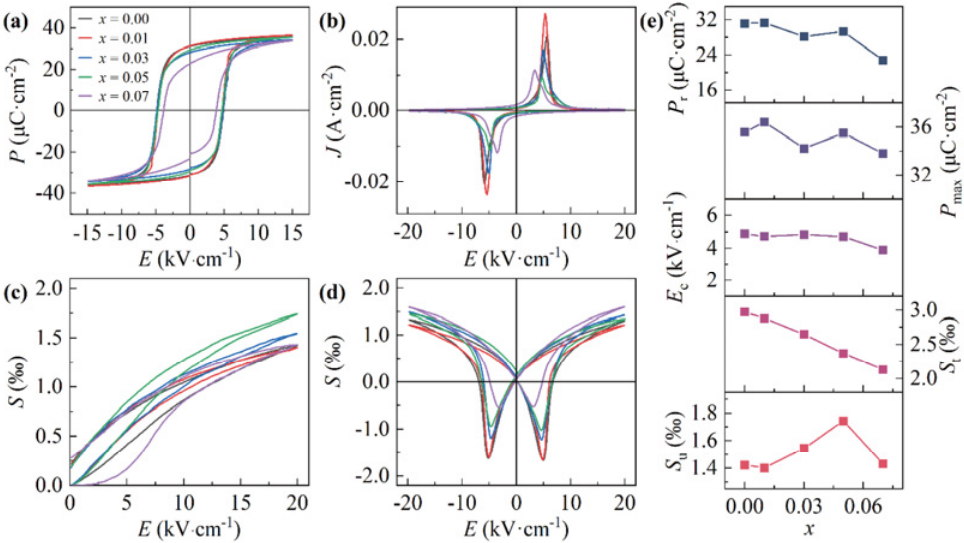
Fig. 4 Polarization and current density vs. electric field: (a) P – E loops and (b) J – E curves of PMN–PT– x BNZ ceramics. (c) Unipolar S and (d) bipolar S curves at 20 kV·cm − 1 of samples. (e) Variation of P r , P max , E c , S t , and S u as a function of BNZ